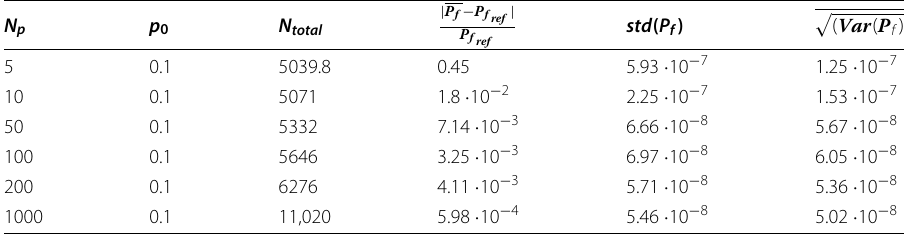
Table 2 1D truss: influence of the number of samples N p with a fixed p 0 = 0 . 1 in the adaptive design point estimation using the analytic limit state function (50 runs with N = 5000 ) N